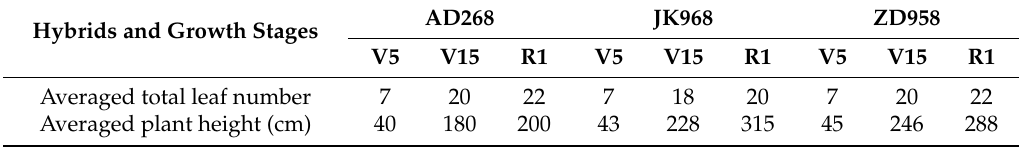
Table 1. Morphological description of three hybrids maize plants at three growth